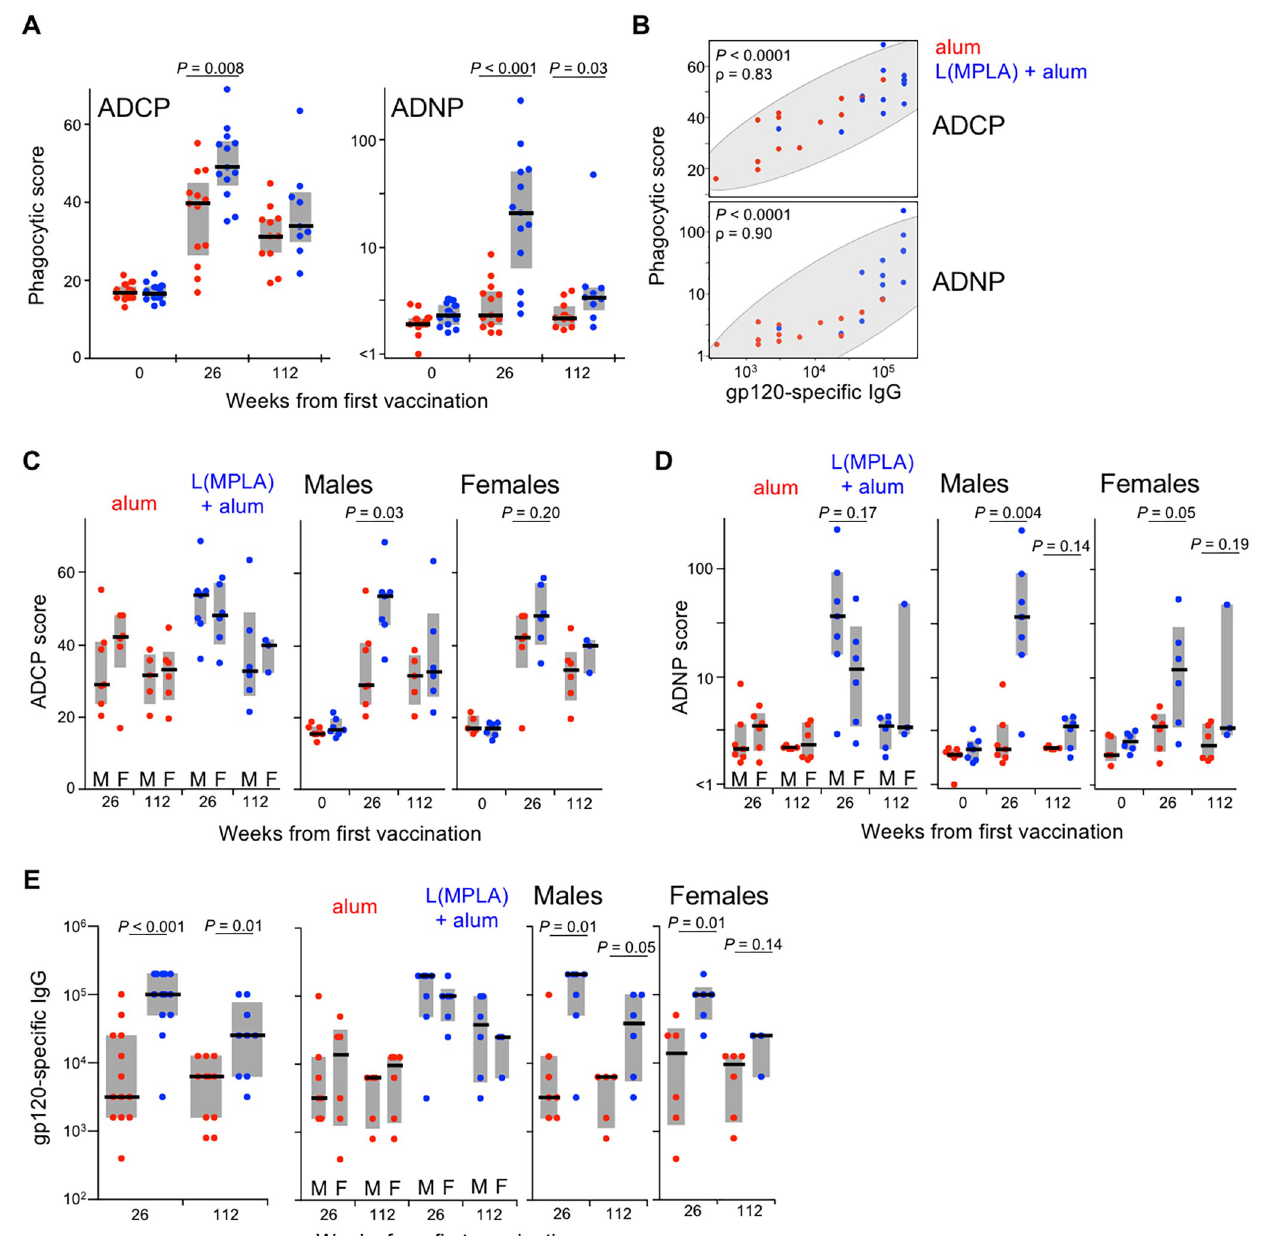
Fig 5. Env-specific antibody-dependent phagocytic responses elicited by liposomal-MPLA-alum adjuvant in humans. (A) Serum ADCP and ADNP responses in humans vaccinated at weeks 0, 8, 24, and 72 with HIV-1 SF-2 gp120 protein adjuvanted with either alum (red) or liposomal-MPL adsorbed to alum (blue) were assessed at weeks 0 (n = 12 and 13, respectively), 26 (n = 13 each arm), and 112 (n = 11 and 9, respectively). (B) Week 26 ADCP and ADNP responses are plotted against week 26 gp120-specific binding IgG endpoint titers with Spearman’s rho and P values indicated. (C) ADCP and (D) ADNP responses are stratified by participant sex to compare responses within each adjuvant study arm (left; M, male; F, female) or between arms within each sex (right). (E) gp120 IIIB Env-specific binding IgG endpoint ELISA titers are shown for all participants combined (left), by sex within each vaccine arm (middle), and by arm within each sex (right). Gray bars depict interquartile range; black lines depict medians; P values reflect Wilcoxon rank-sum test.